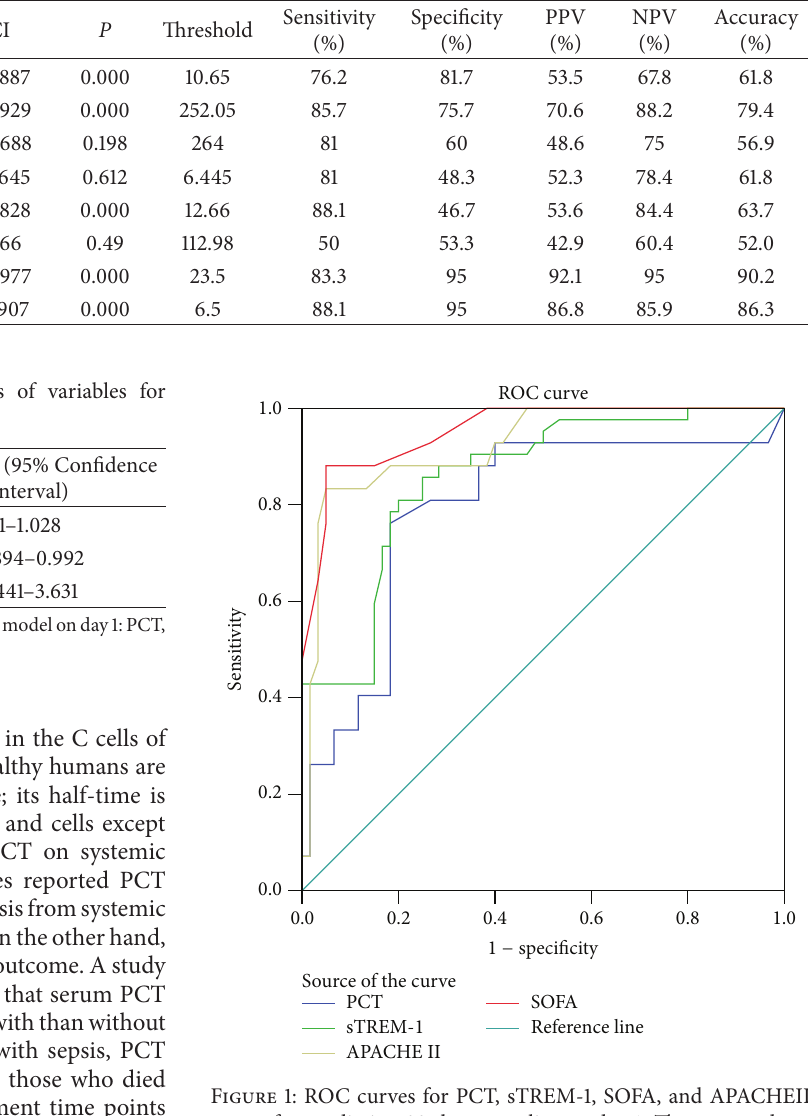
Figure 1: ROC curves for PCT, sTREM-1, SOFA, and APACHEII scores for predicting 28-day mortality on day 1. The area under a ROC curve for the prediction of 28-day mortality was 0.792 for PCT, 0.856 for sTREM-1, 0.953 for SOFA score, and 0.923 for APACHEII score. PCT and sTREM-1 showed the equal prognostic values which were inferior to SOFA and APACHEII scores (𝑃 < 0.05)